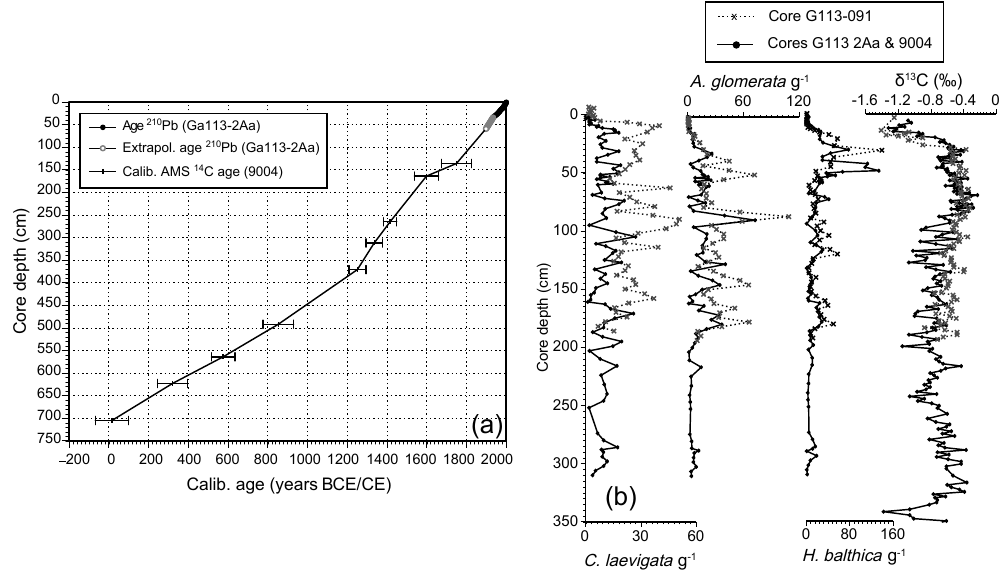
Figure 3. Age model of the studied Ga113-2Aa and 9004 records (a) and the comparison of foraminiferal and isotopic data with core G113- 091, taken at the same location in 2009, to prove the absence of a gap between GA113-2Aa and 9004 (b) , according to Polovodova Asteman et al. (2013). Table 1. Stations with collected sediment core tops and δ 18 O analyses on living (Rose Bengal stained) Cassidulina laevigata . Station Latitude ( ◦